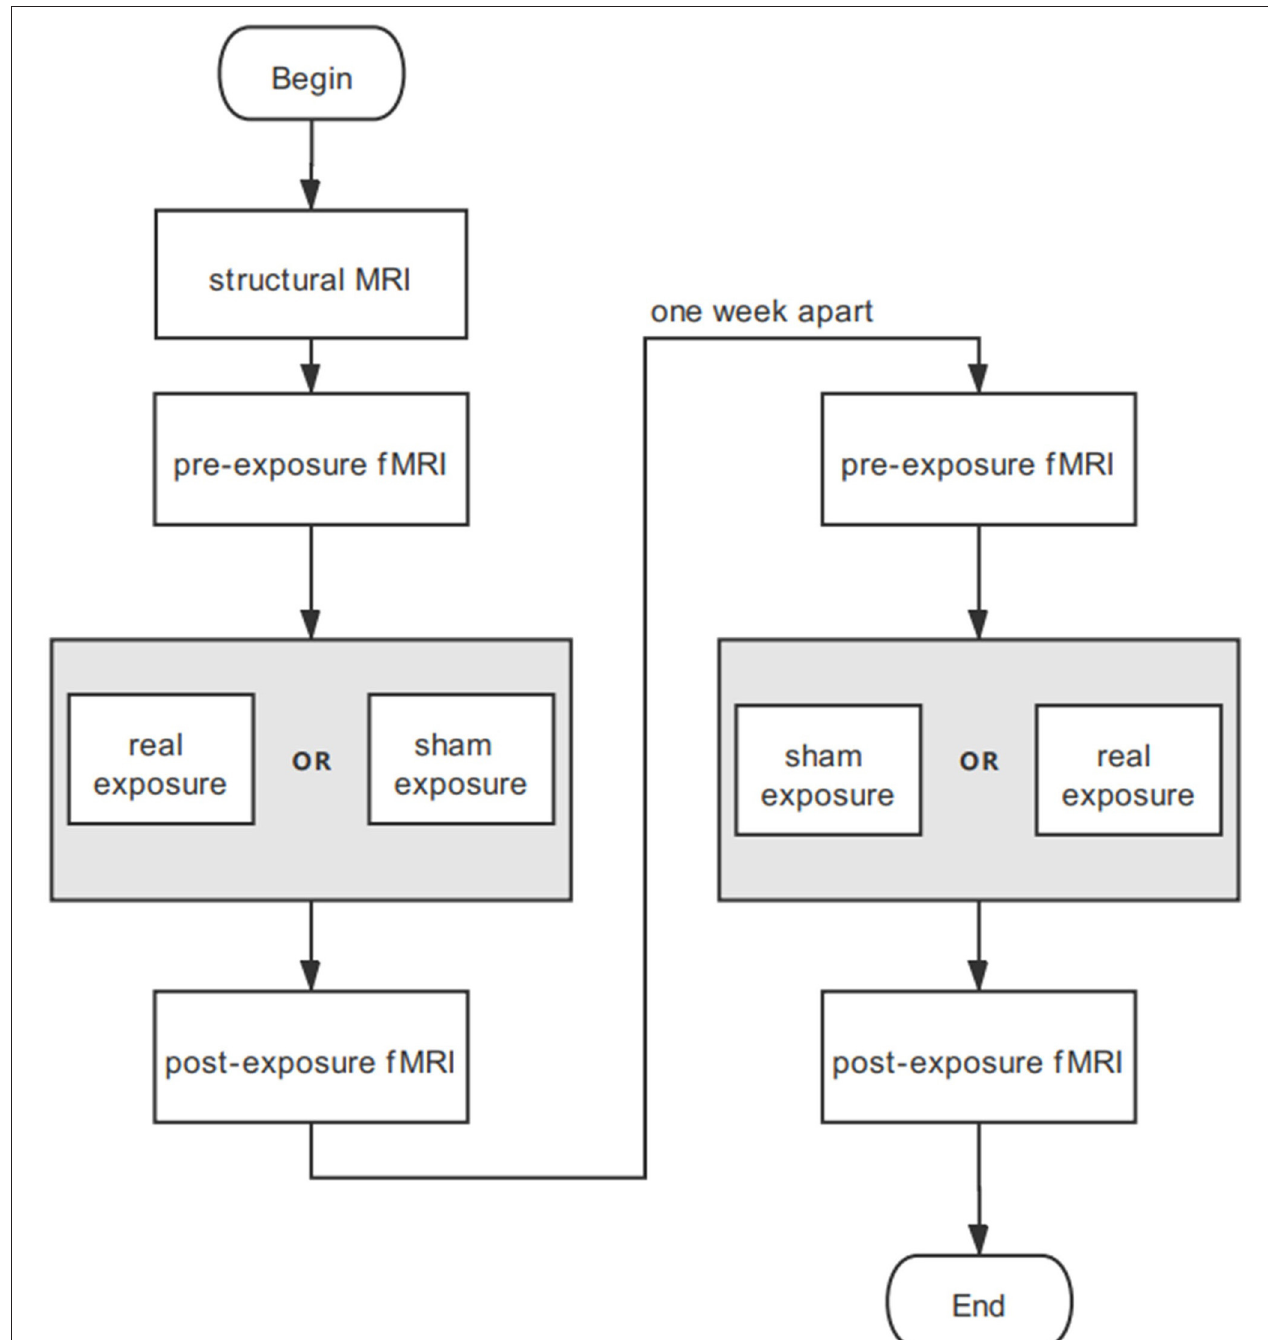
FIGURE 1 | Experimental procedure for each participant. Neither participants nor operators know the exposure